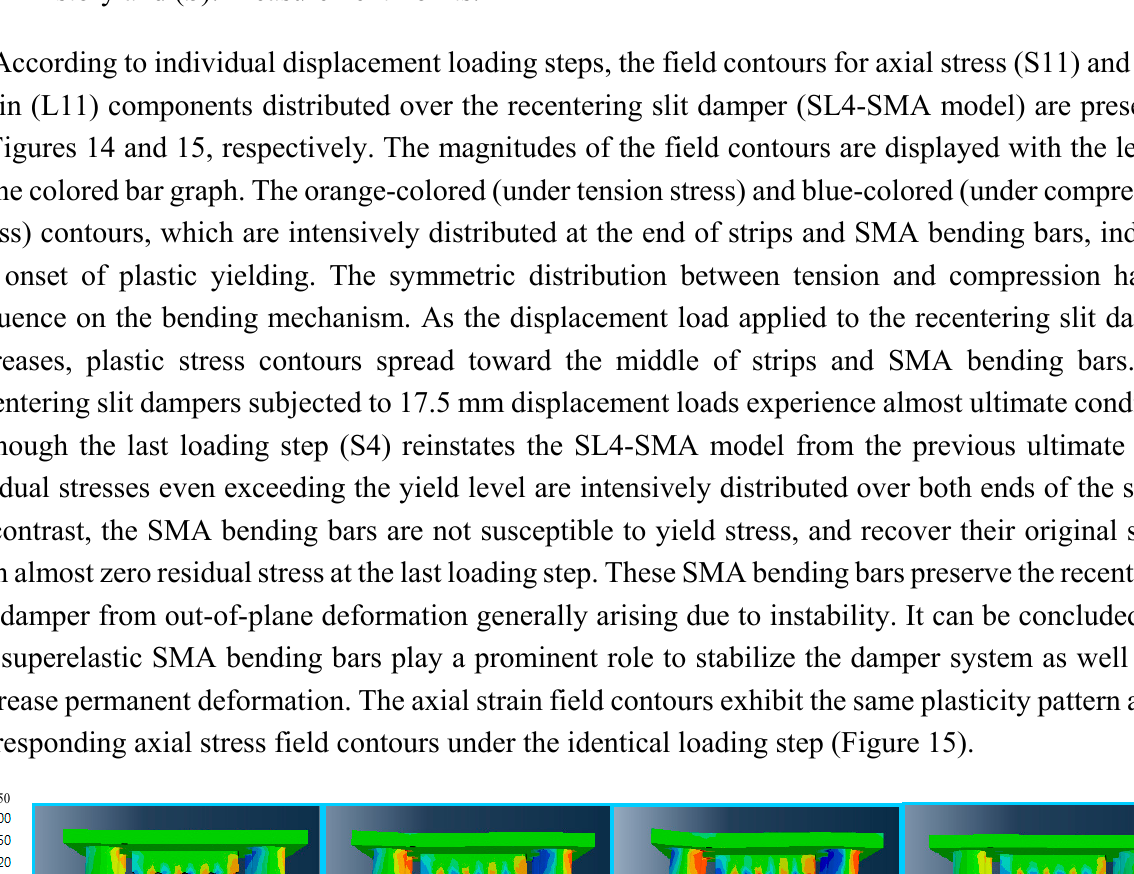
Figure 13. Target loading steps for field contour observation, ( a ): Displacement Loading History and ( b ): Measurement Points.